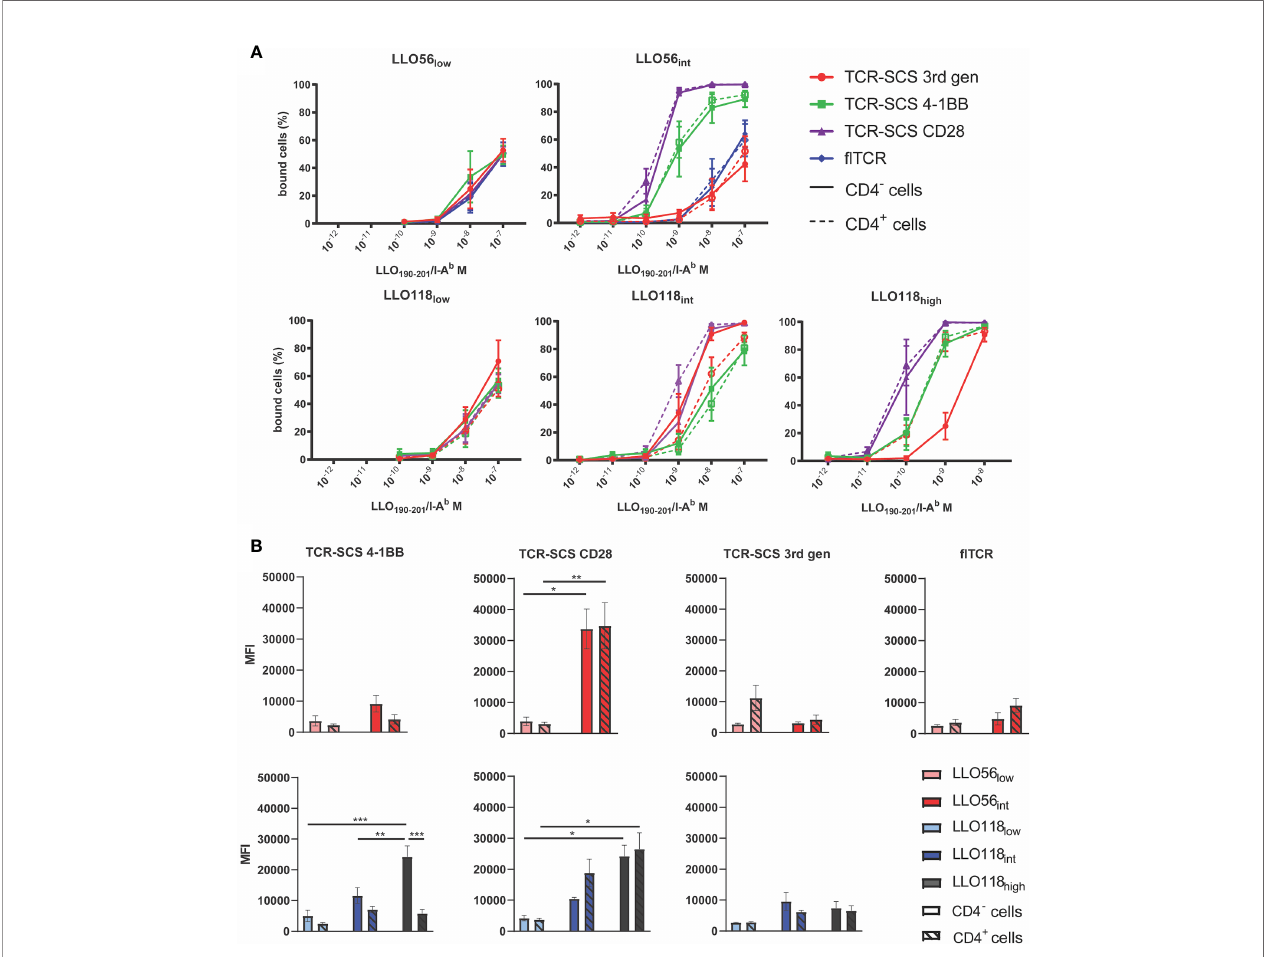
FIGURE 4 | TCR-pMHCII avidity is affected by construct format. (A) fl TCR or TCR-SCS expressing cell lines were incubated with varying amounts of LLO 190-201 /I- A b tetramer (10 -7 M to 10 -12 M) at room temperature for 2 h. Each TCR-format pair expressed in CD4 - cell lines (solid lines) and CD4 + cell lines (dotted lines) have similar af fi nities, whereas each unique construct format alters avidity of a single TCR. Representative of three independent measurements of 20,000 cells via fl ow cytometry. (B) Tetramer MFI measurements of 10 -8 M separated by TCR and format where CD4 - cell lines (solid bars) and CD4 + cell lines (hashed bars) are paired. *<0.05, **<0.01,